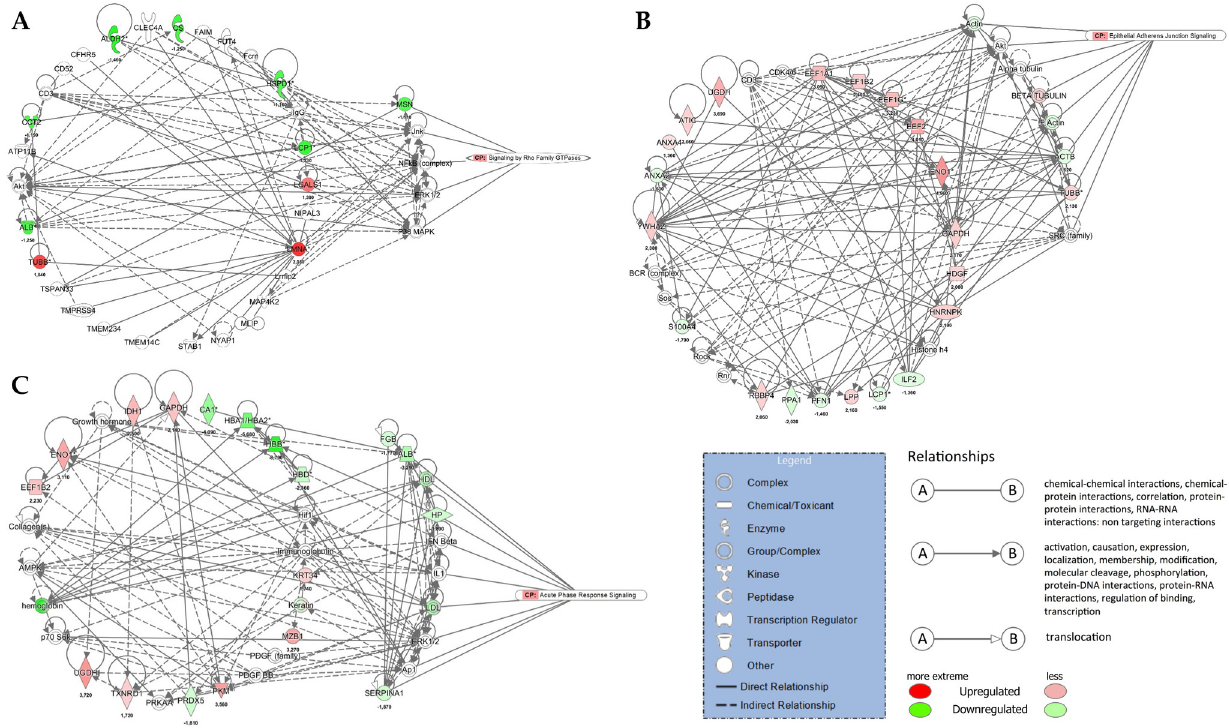
Fig 6. IPA networks for ADC. (A) margin vs. center comparison in ADC. Cellular Movement, Hematological Disease, Immunological Disease Network is presented together with Signaling with Rho GTPases canonical pathway; (B) center vs. control comparison in ADC. Cellular Movement, Hematological Disease, Immunological Disease is presented together with Signaling with Epithelial Adherens Junction Signaling canonical pathway and (C) margin vs. control comparison in ADC. Cardiovascular Disease, Free Radical Scavenging, Small Molecule Biochemistry is presented together with Acute Phase Response Signaling canonical